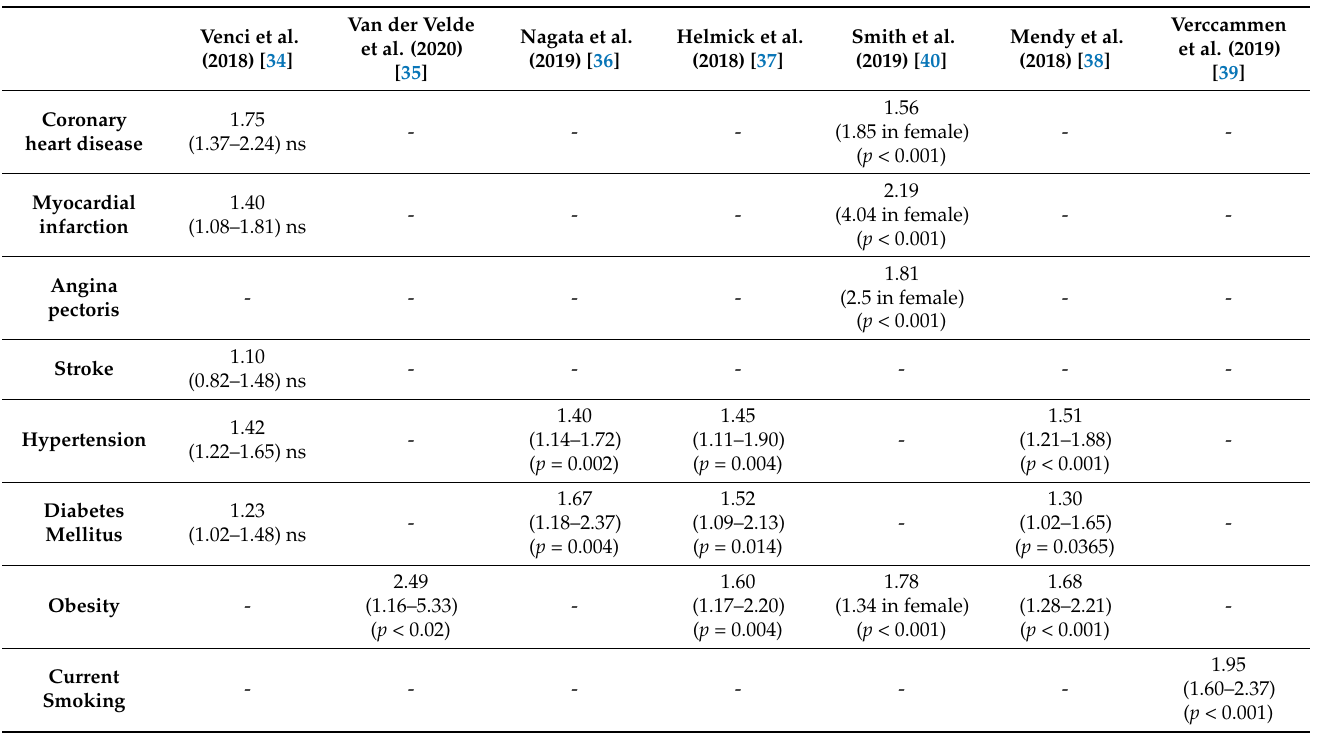
Table 3. Influence of food insecurity in the development of NCDs, expressed as odds ratio and 95% CI.